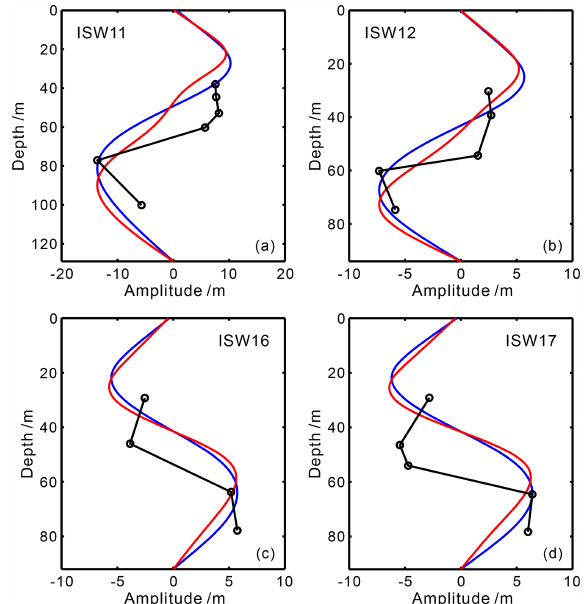
Figure 12. Panels (a) – (d) demonstrate the vertical structure charac- teristics of the amplitude of the four mode-2 ISWs (ISW11, ISW12, ISW16, and ISW17) on survey line L74 as well as the vertical mode function fitting results. The black circles denote the observed ISWs’ amplitudes at different depths. The blue curves are the linear verti- cal mode function (nonlinear correction is not considered) and the red curves are the first-order nonlinear vertical mode function (non- linear correction is